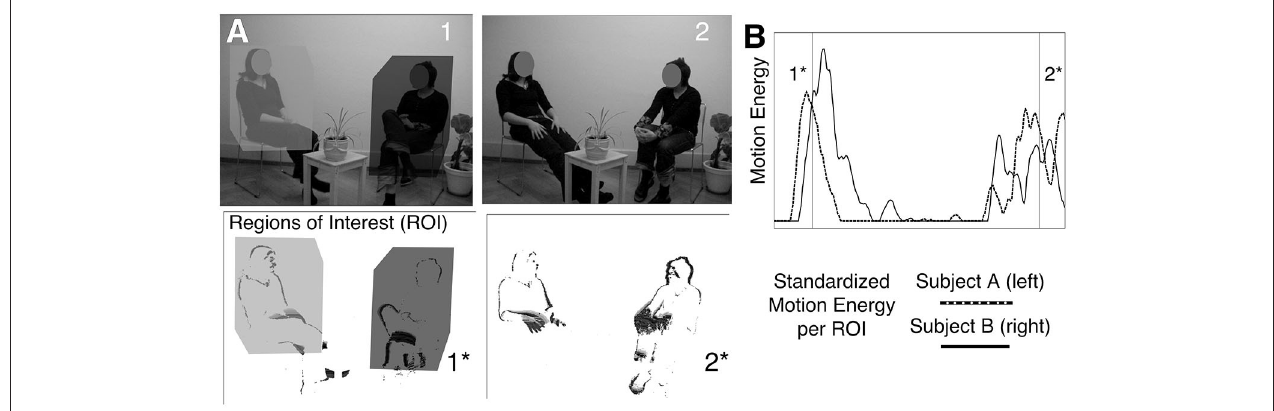
FIGURE 7 | Motion Energy Analysis (MEA): Panel (A) : Top row = Original Movie (1, 2). Bottom Row = Frame-Differenced Pictures (1*, 2*). Panel (B) : Motion Energy per Region of Interest (ROI).